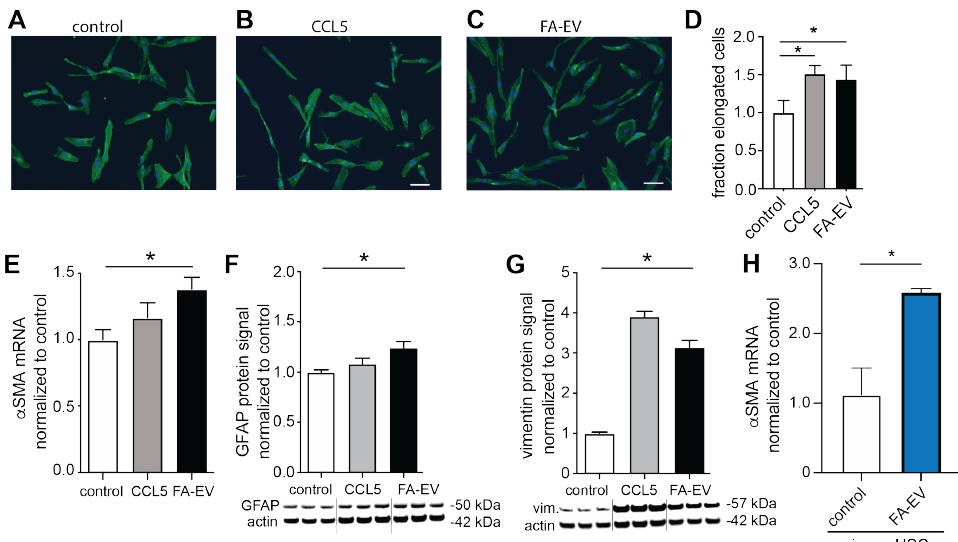
Figure 4. Morphology and phenotypic markers of FA-EV–treated TWNT4 cells and primary HSC. Representative phalloidin staining after treatment of TWNT4 cells with vehicle ( A ), CCL5 ( B ) or FA- EVs ( C ). Scale bar: 100 µ m. ( D ) Quantitation of elongated cells from the micrographs (n = 3). mRNA expression of α - SMA ( E ), and antigen levels of GFAP ( F ) and vimentin ( G ) after treatment with vehicle, CCL5 or FA-EVs. ( H ) Primary HSCs were treated with or without FA-EVs, and mRNA expression levels of α - SMA were measured. * p < 0.05 with ANOVA and Bonferroni test; mean ± SEM (n =